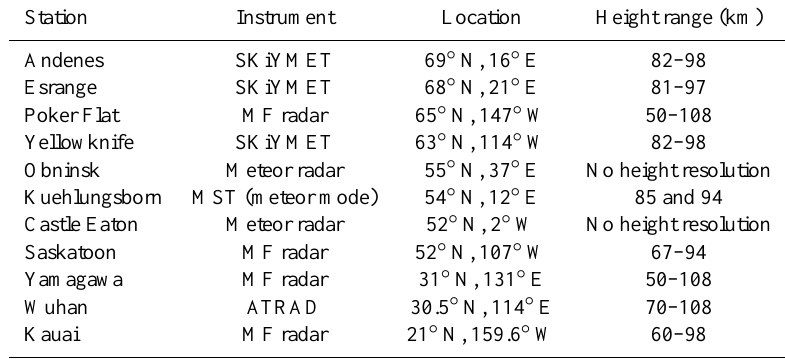
Table 1. Geographic locations of the radars, the type of the instrument and the height range of available measurements. Station